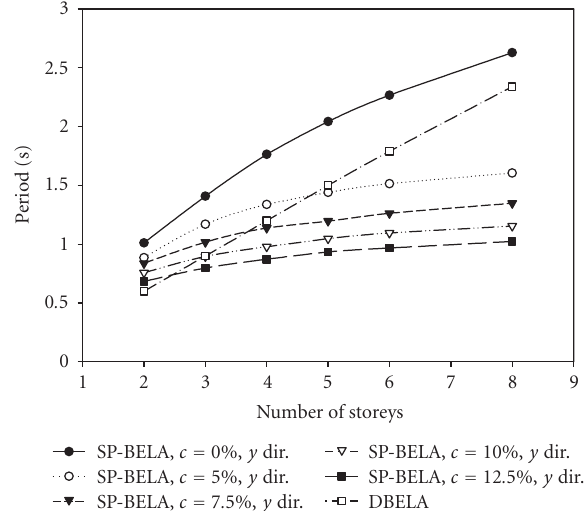
Figure 9: Mean yield period of vibration versus number of storeys for DBELA compared with each of the SP-BELA design categories in the y direction.